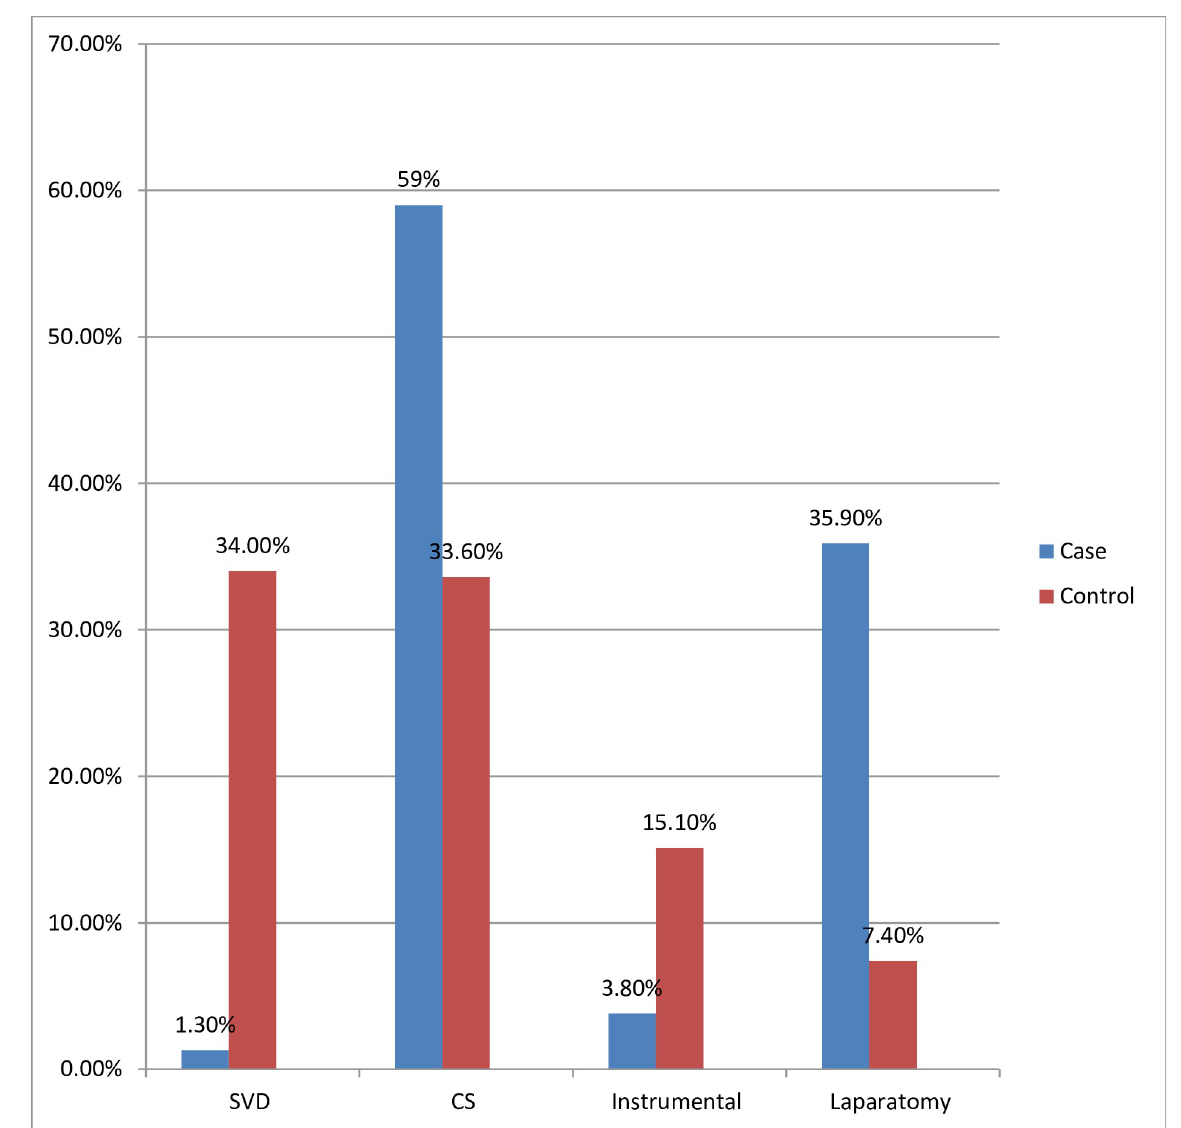
Fig 1. Management options of obstructed labour in HUCSH, Ethiopia